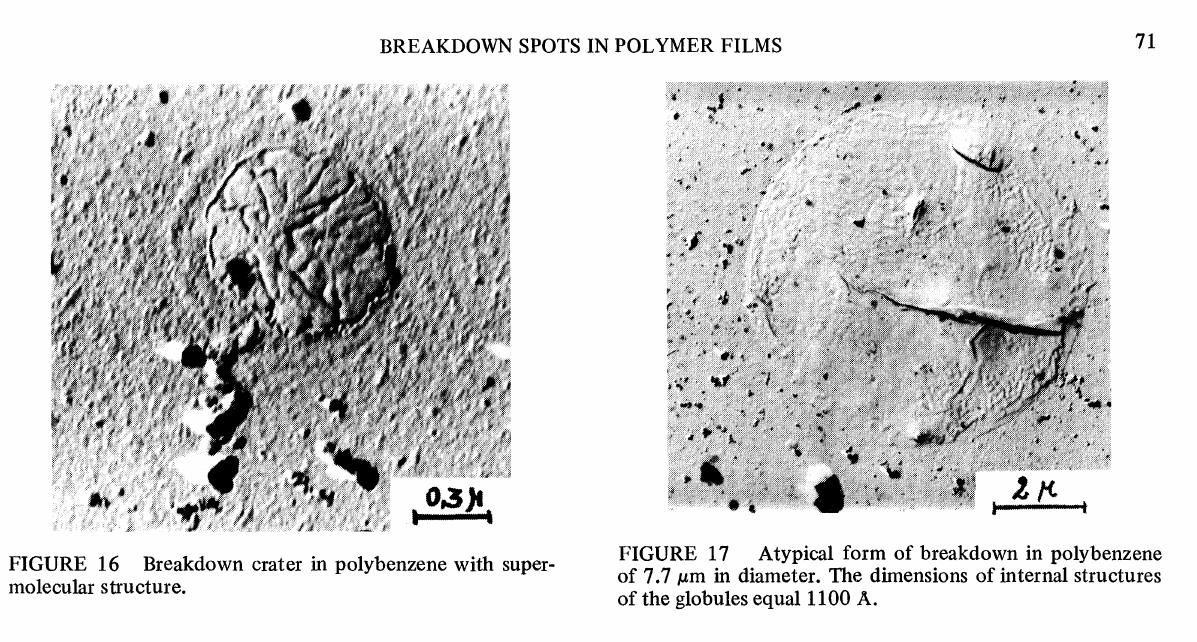
FIGURE 17 Atypical form of breakdown in polybenzene of 7.7 pm in diameter. The dimensions of internal structures of the globules equal 1100 A.